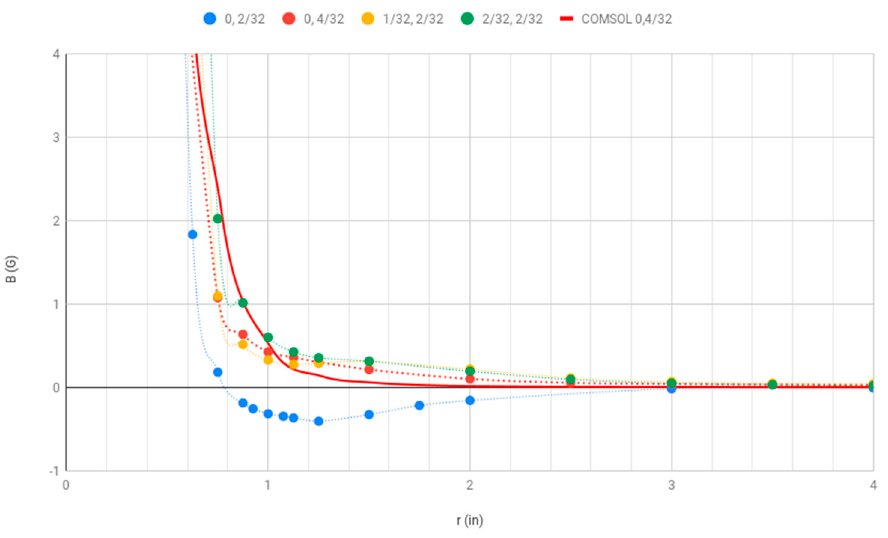
Figure 12. Transverse ( ρ ) far-field B z measurements for variations in the inner-outer pair separa- tion (first value) and gap (second